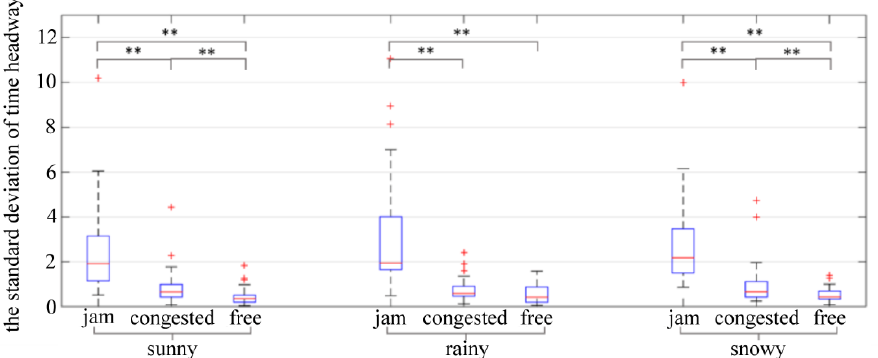
Figure 11. The standard deviation of time headway. ** indicates the variable was statistically significant at 0.05 level. + indicates outlier.